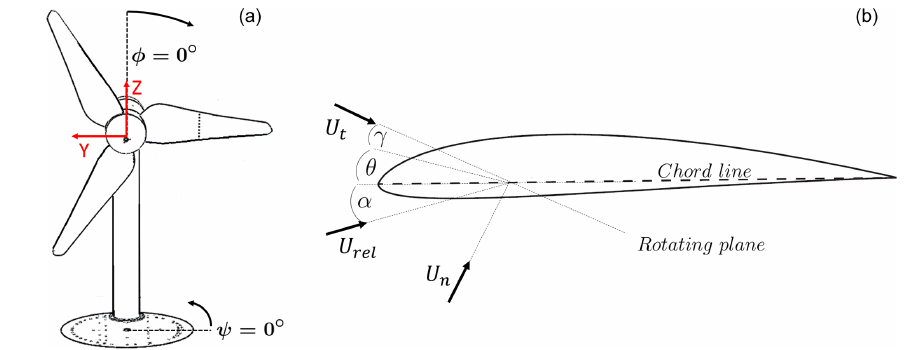
Figure 3. Angle definition. Azimuth, φ , and yaw, ψ (a) . Angle of attack, α ; pitch, θ ; and twist, γ . U t , U n and U rel are the tangential, normal and relative velocities, respectively (b) .